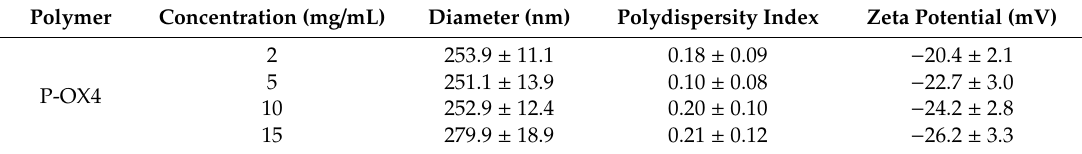
Table 4. Characteristics of nanoparticles prepared from P-OX4 by nanoprecipitation ( n = 3; ± SD). Polymer